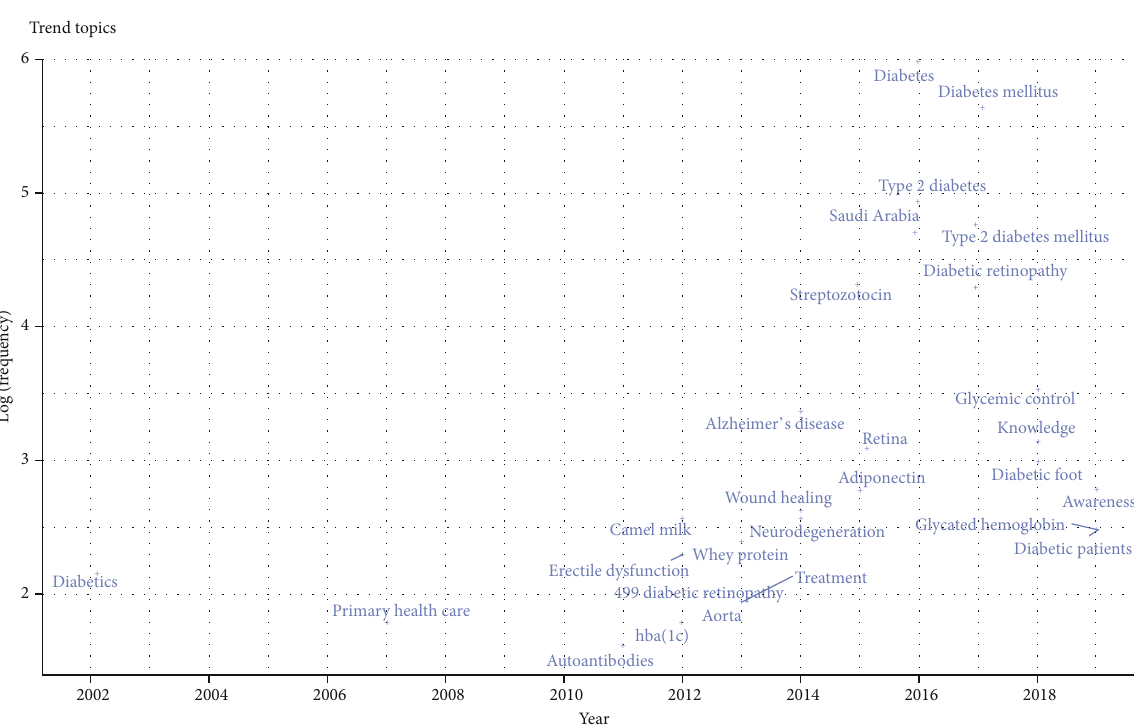
Figure 5: Occurrences of most frequent keywords.